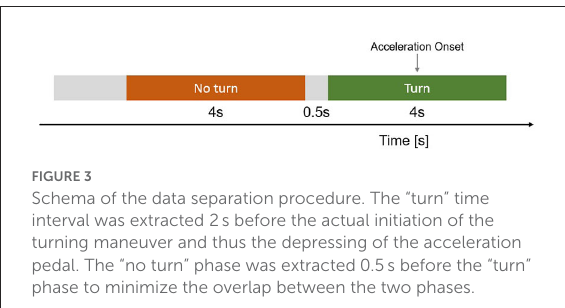
FIGURE3 Schema of the data separation procedure. The “turn” time interval was extracted 2s before the actual initiation of the turning maneuver and thus the depressing of the acceleration pedal. The “no turn” phase was extracted 0.5s before the “turn” phase to minimize the overlap between the two